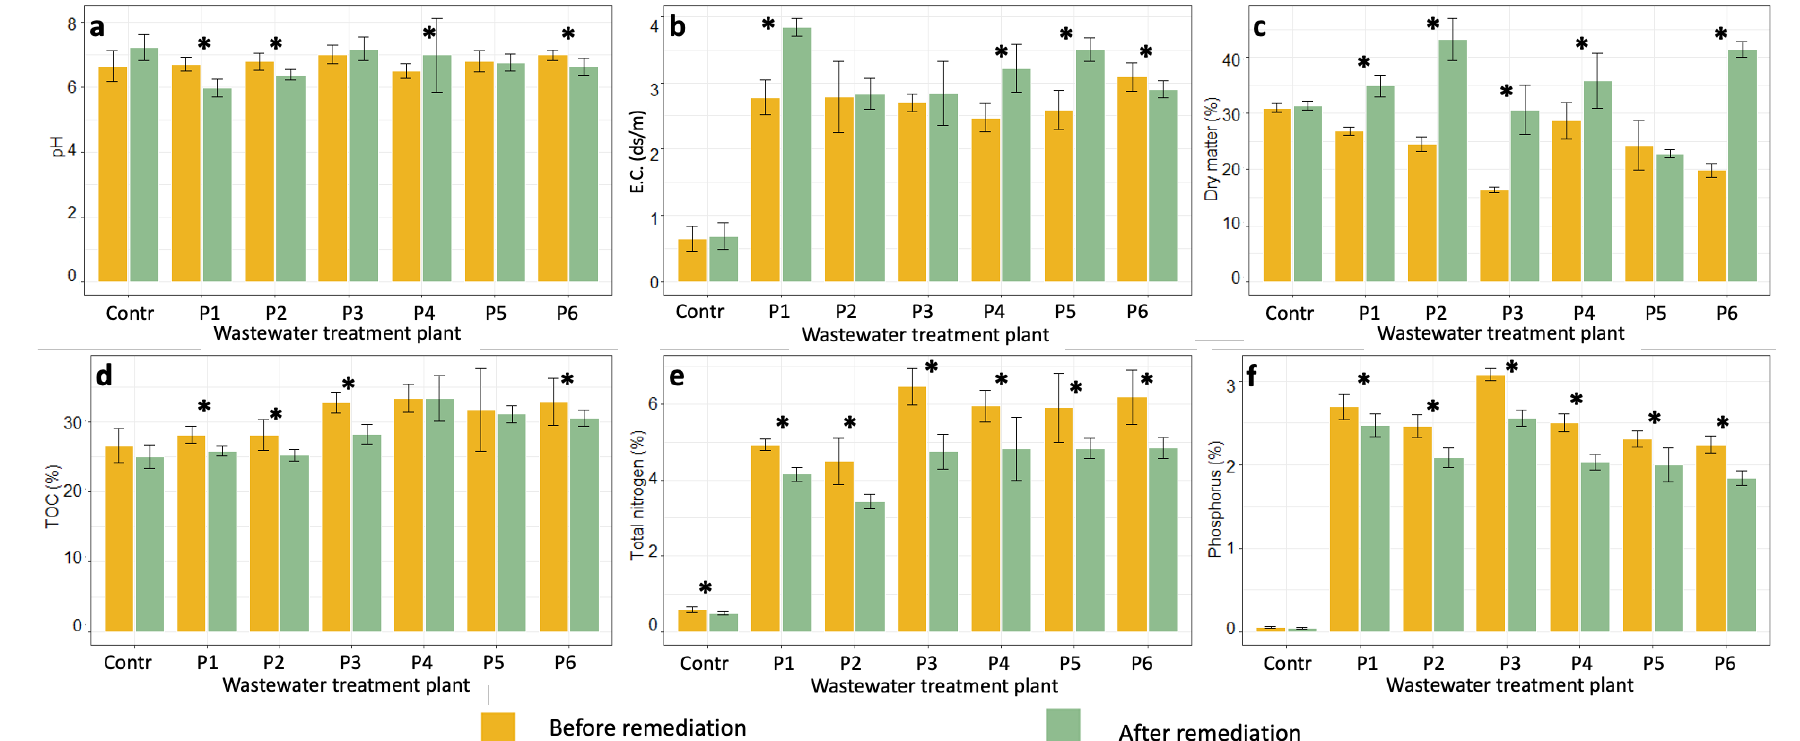
Figure 2. Effects of phytoremediation on SS physical and chemical characteristics. ( a ) pH; ( b ) electrical conductivity (EC); ( c ) dry matter content; ( d ) total organic carbon (TOC); ( e ) total nitrogen; ( f ) phosphorus. Each value is the average of 5 replicates ( n = 5). Stars above each couple of columns identify significant differences before and after the remediation process ( t -test, p < 0.05). Complete datasets in Supplementary Tables S1 and S4.